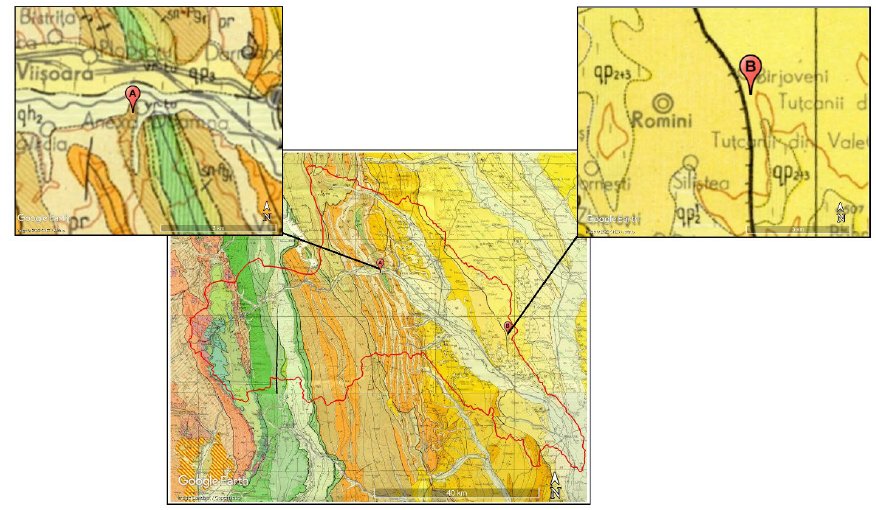
Figure 4. Geology of the Bistrița River basin and the two investigated settlements: A . Piatra Neamț — Bâtca Doamnei and B. Siliștea — Pe Cetățuie (Georeferenced Geological Map of Romania).